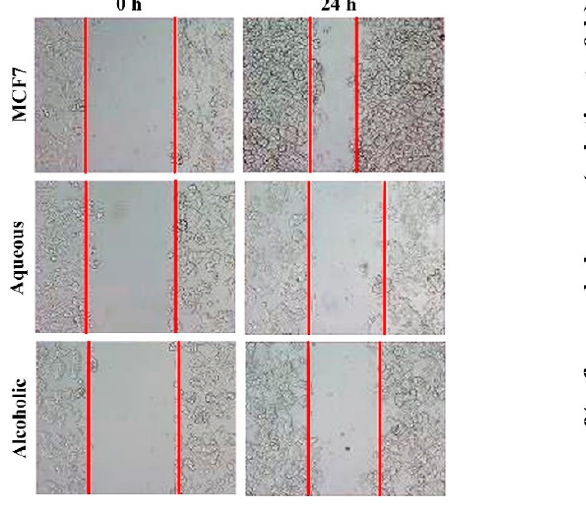
( C ) Figure 7. Anti-migratory effect of 5% aqueous and alcoholic larval extracts on MCF7 cells. ( A ) Wound-healing assay. ( B ) Percentage of wound closure of MCF7 cells. ( C ) Expression of MMP9 and TIMP1 genes in MCF7 cells. Data are expressed as the mean ± SEM. Samples were run in triplicate in three independent experiments, n = 5. Groups with different letters are significantly different at p < 0.05. * indicates high significance with respect to the control ( p < 0.01). 3.7. Larval Extracts Reduced the Expression of Inflammation-Related Genes The inflammatory genes NF κ B and IL8 exhibited a significant downregulation after the addition of each extract compared to the control cells (Figure 8). The most downregulated effect was encountered in cells treated with the 5% alcoholic extract. These findings indicate that these extracts have an anti-inflammatory effect against MCF7 cells, with the best effect being for the 5% alcoholic extract.